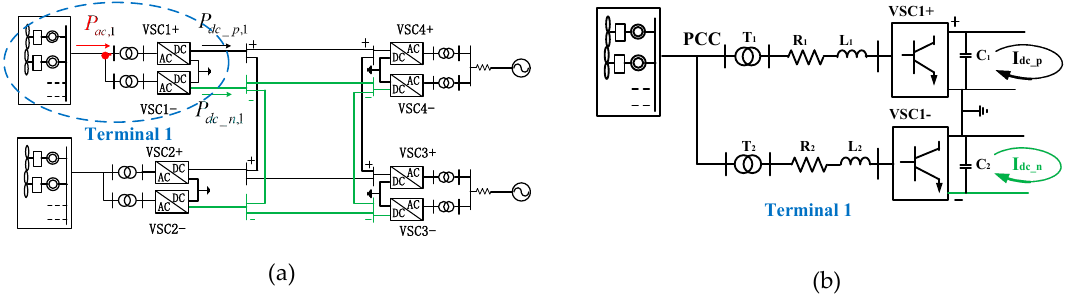
Figure 1. A bipolar multi-terminal voltage source converter-based high voltage direct current (VSC-MTDC) system. ( a ) The topology of a bipolar VSC-MTDC; ( b ) Structure of one terminal of a bipolar VSC-MTDC.